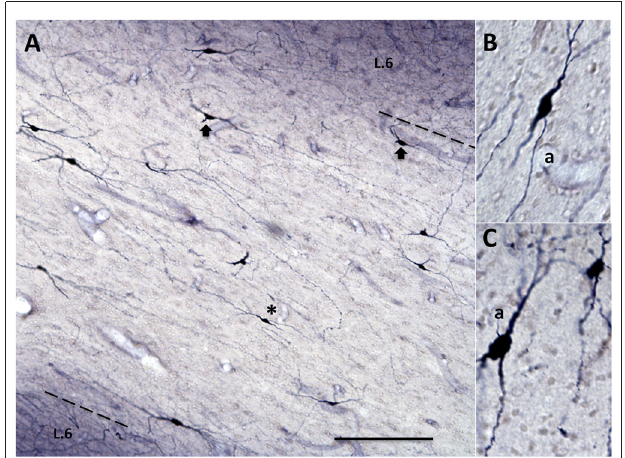
FIGURE 8 | Subpopulation of inhibitory WMNs, visualized by NADPH-diaphorase. (A) WMNs in the temporal ROI, between the upper bank of the superior temporal sulcus and the lower bank of the lateral sulcus (medial is at the right). Note extensive dendritic trees and different soma size and shape. Dashed line indicates border of layer 6 (L.6) and white matter. (B) Higher magnification of a fusiform neuron (from asterisk in A ), and in (C) of fusiform and granular neurons (from a ventrally adjacent field). a = axon. Scale bars = 200 µ m in (A) ; 50 µ m in (B,C)